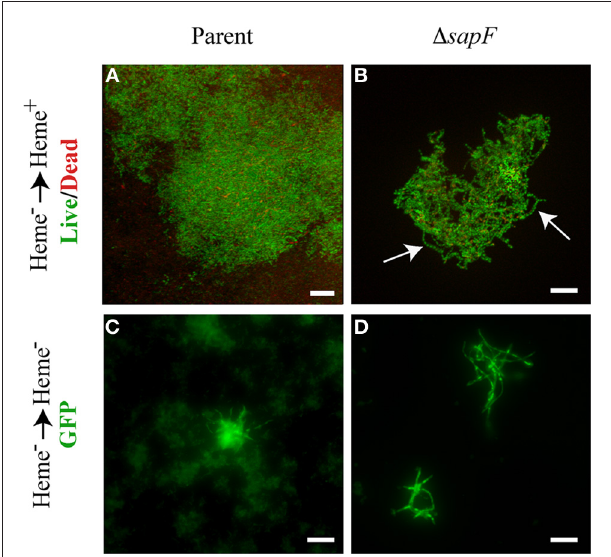
FIGURE 6 | Morphological plasticity in the absence of SapF. The parental strain (A, C) and the SapF-deficient strain (B, D) were cultured in DIS medium without heme for 16h, matched for OD 490 units, and then sub cultured into chamber slides (1 × 10 6 CFU/mL starved) with DIS medium with (A, B) or without heme (C, D) for 48h. (A, B) Biofilms were stained with the Live/Dead viability stain and colony morphology was analyzed by fluorescence microscopy. 3D rendering of sequential optical sections of the SapF-deficient strain demonstrating lace-like architecture composed of chaining nucleoids (B) as compared to mat-like architecture of the parent (A) . The parent strain (86-028NP rpsL A 128 G /pGM1.1; C ) forms fewer filamentous individuals while the SapF-deficient strain (86-028NP rpsL A 128 G (cid:2) sapF /pGM1.1; D ) readily filaments under heme-starved conditions. All images were taken under 63 × magnification. Scale bar = 10 μ